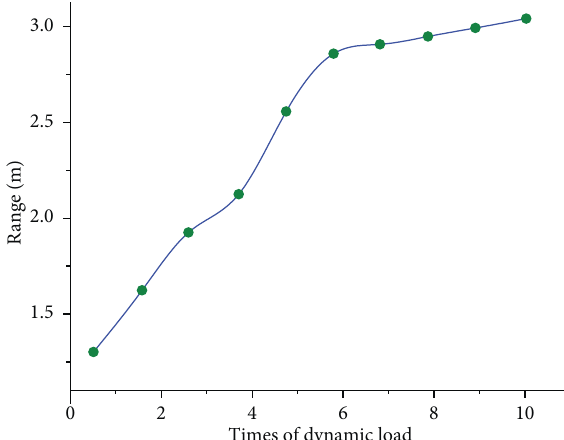
Figure 4: Curve showing the increasing range of plastic zone on the side of a small pillar relative to multiple dynamic loads.